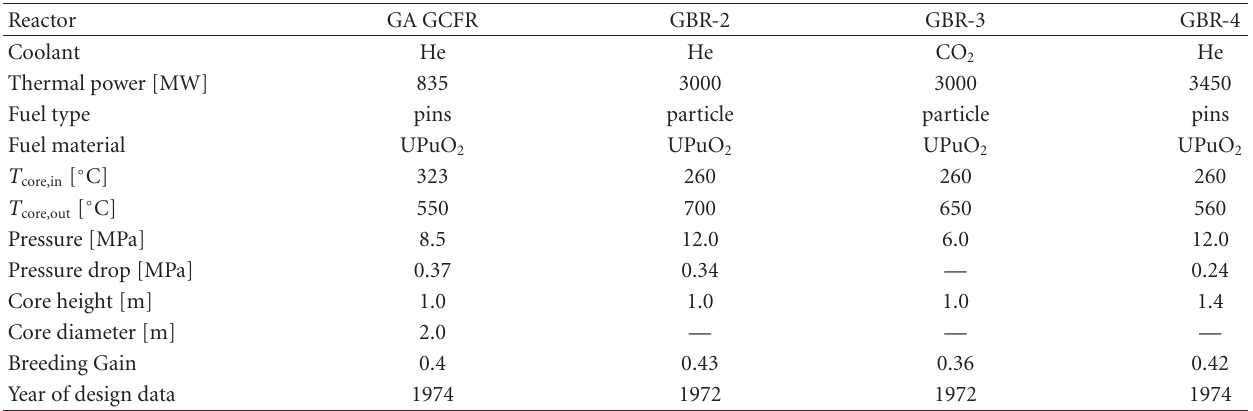
Table 1: Design data for four early GCFR proposals. The small General Atomics GCFR was envisaged as a prototype, the GBRs were envisaged as large-scale commercial systems. From the three GBR concepts, the GBR-4 was adopted as the reference design. Note: pressure drop is over entire primary circuit for GA design; core only for GBR designs. GA GCFR